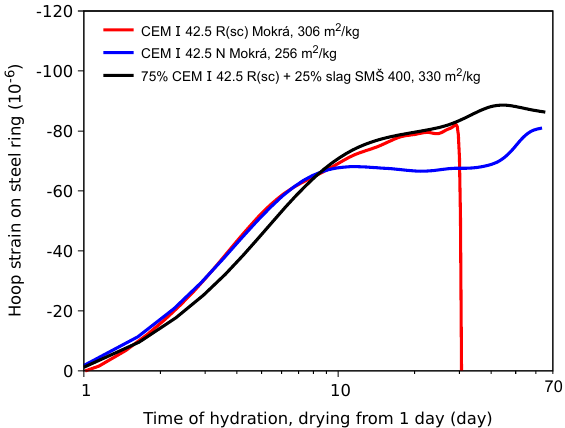
Figure 7. Hoop strain on the steel ring for three selected